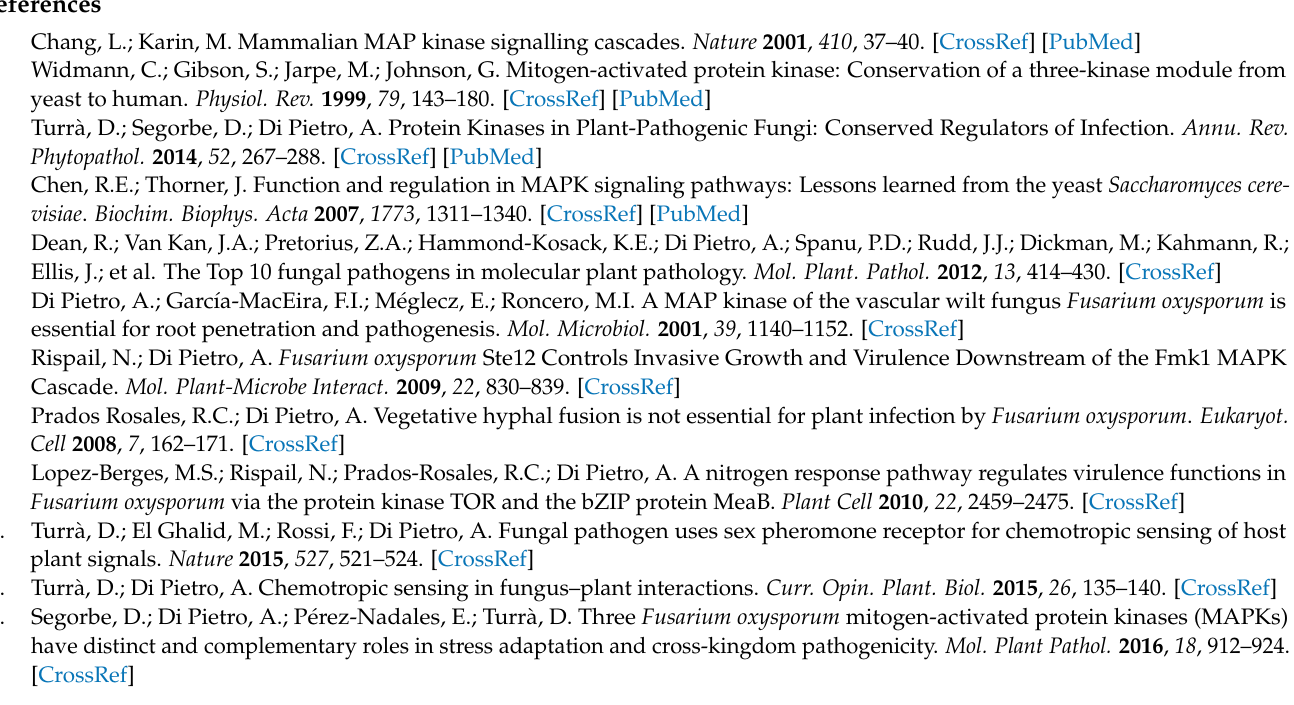
F. oxysporum Pro1 protein; Figure S2: Targeted replacement of the pro1 gene in F. oxysporum ; Figure S3: Pro1 is required for the response to cell wall stress; Table S1: Fungal Pro1 orthologues used for amino acid alignment; Table S2: Fungal strains used in this study; Table S3: Oligonucleotides used in this study; Table S4: Plasmids used in this study; Table S5: Statistical significance of tomato Solanum lycopersicum survival curves after inoculation with indicated Fusarium oxysporum strains, compared with the wild